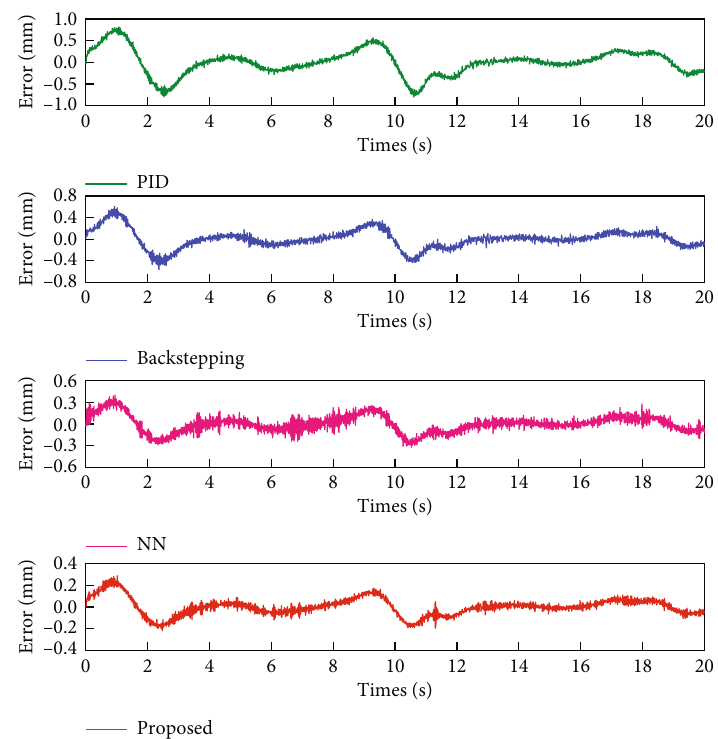
Figure 14: Tracking error of multifrequency sine